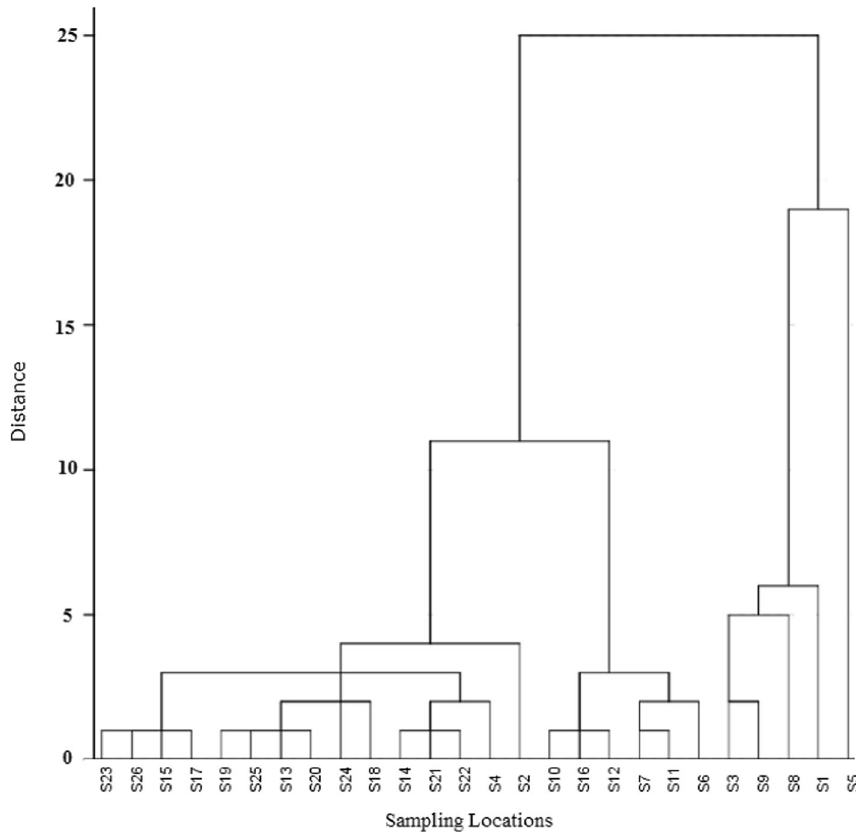
Fig. 4 Cluster analysis of 26 sampling sites based on the ele- ment loading in river